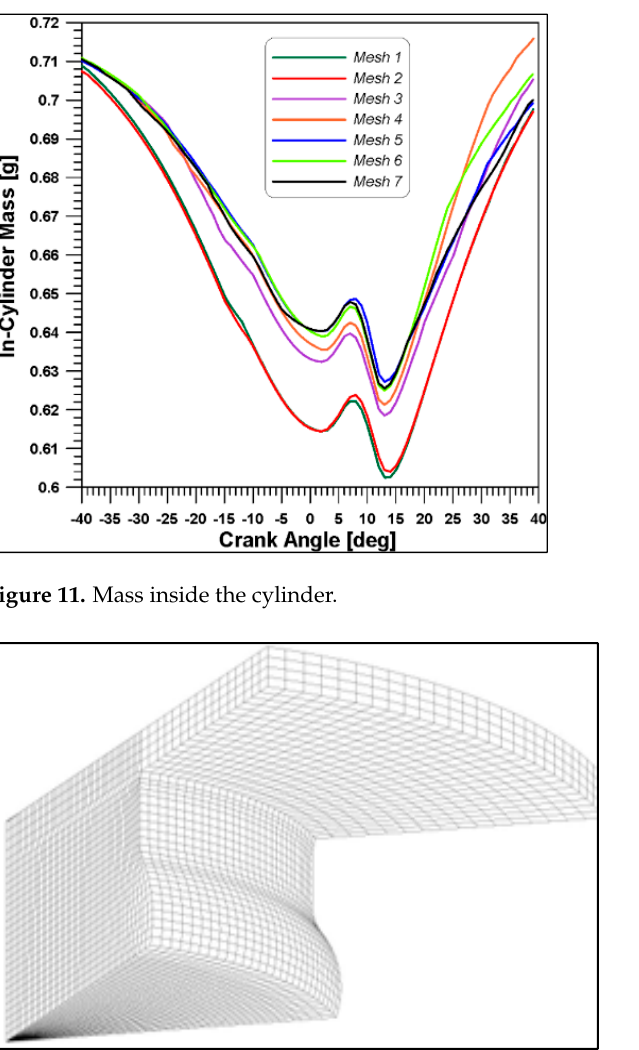
Figure 10. Rate of heat release for the different meshes.